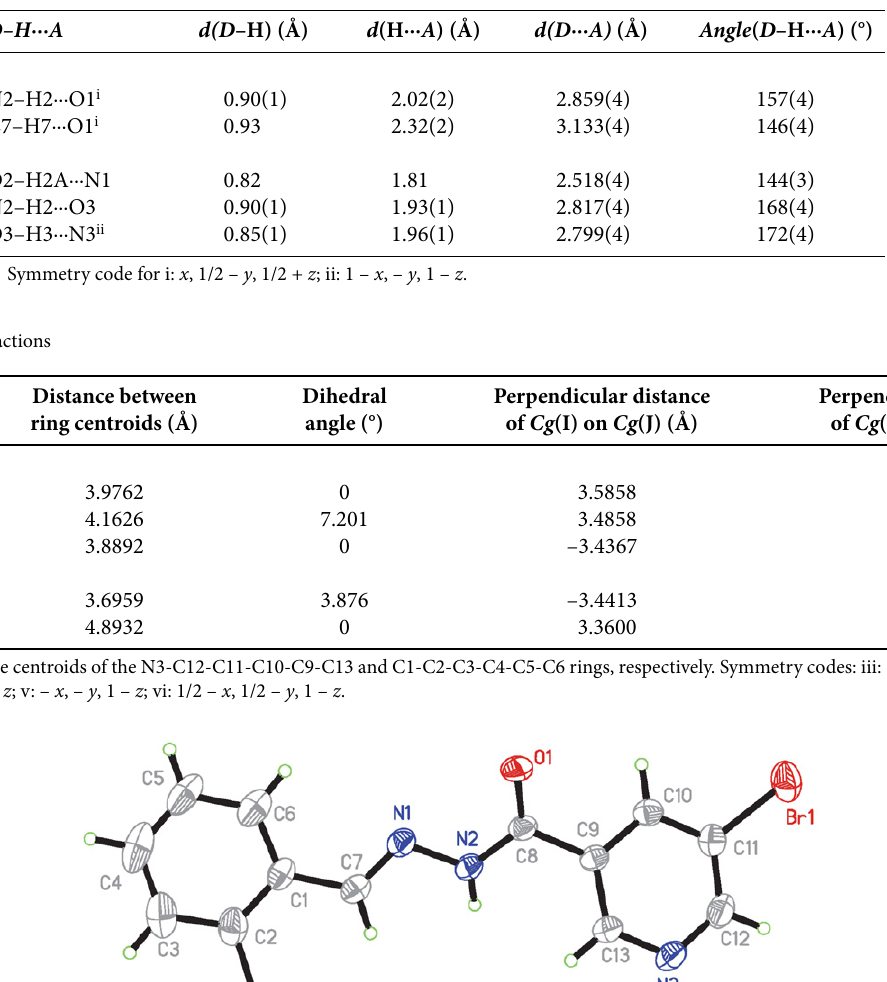
Table 3. Distances (Å) and angles (°) involving hydrogen bonding of the compounds 1 and 2